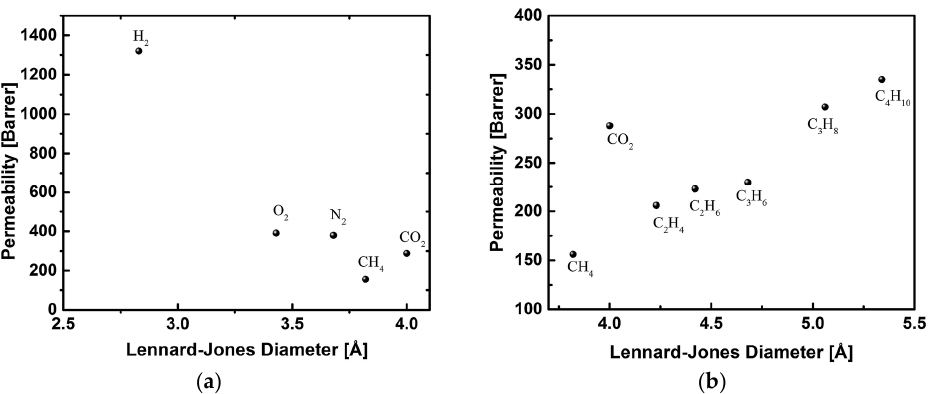
Figure 69. ( Left ) Fe- soc -MOF-1b membrane grown on alumina support and its PXRD pattern compared to the bulk material. ( Right ) Top-view ( a – c , d ) cross-sectional SEM images of the Fe- soc -MOF membrane grown on the alumina support (adapted with permission from ref. [167]).